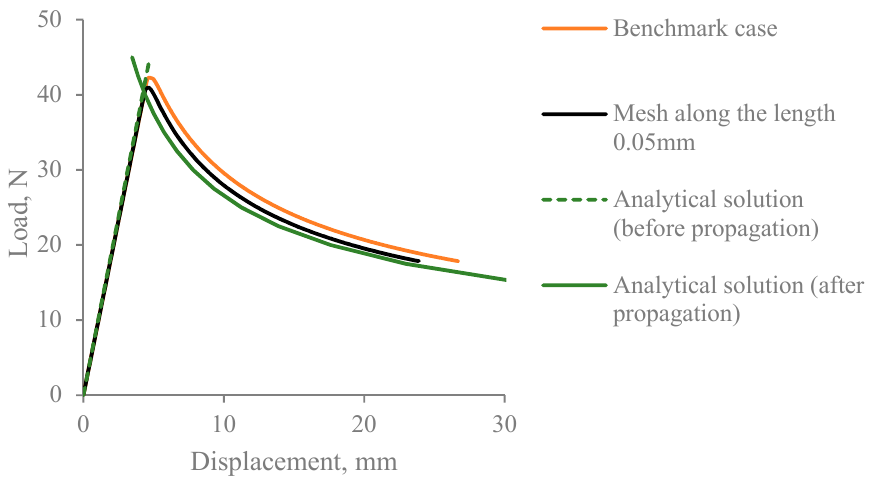
Figure 10. Comparison of the converged solution obtained via FE modelling with an analytical solution from [20,31].